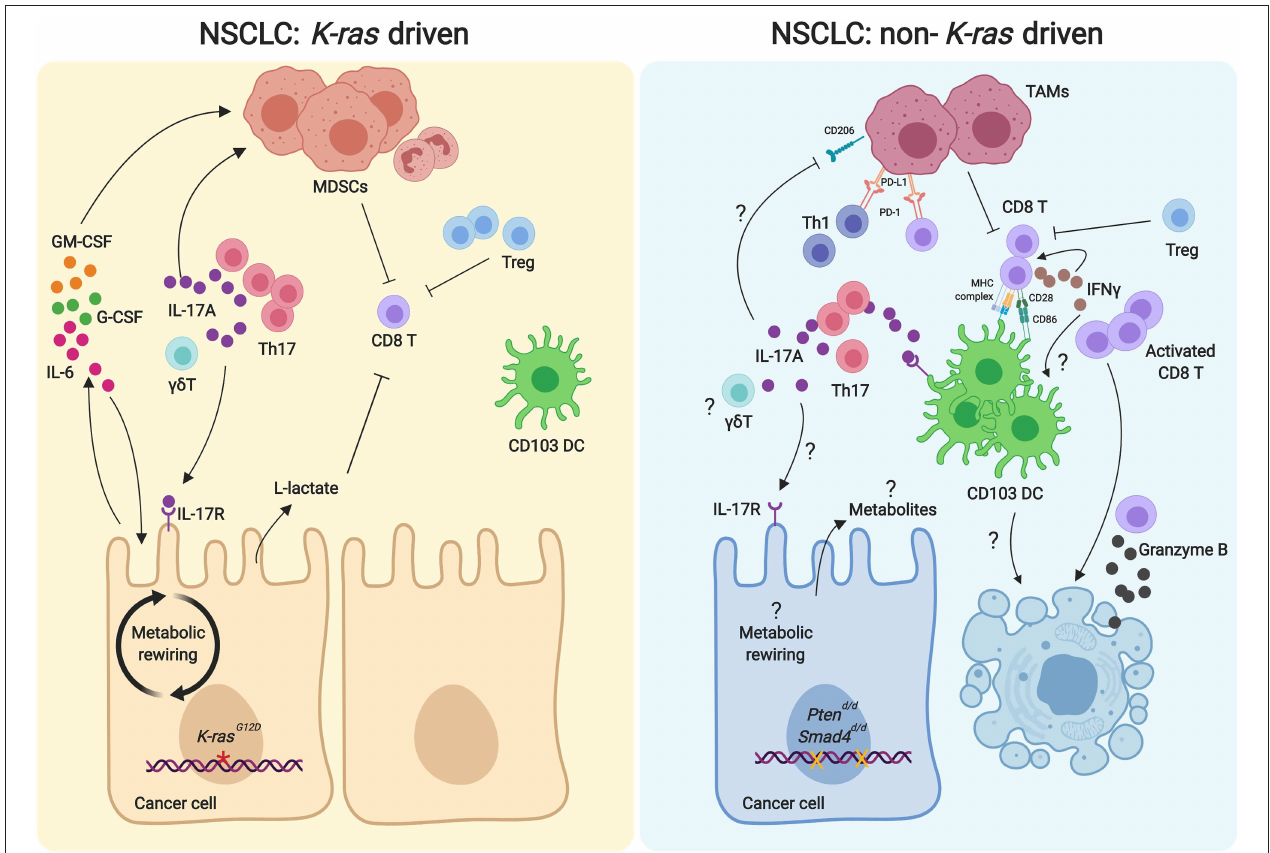
FIGURE 1 | Comparison of Th17/IL17A axis in the tumor microenvironments of K-ras -driven and Pts d / d NSCLC models. In the K-ras -driven models of NSCLC ( Left ), Th17 cells are recruited to the tumor microenvironment to promote tumor cell growth. Th17 derived IL17A recruits MDSCs to suppress the anti-tumor activity of CD8T cells. Increased Tregs and the glycolytic metabolite lactate in the tumor microenvironment can also inhibit the CD8T cell activation. IL17A can directly signal the tumor cells, resulting in increased IL-6 expression. IL-6 can act as an autocrine manner to foster the proliferation of tumor cells and paracrine manner to stimulate the MDSC recruitment. Additionally, GM-CSF and G-CSF produced by the tumor cells can further promote the infiltration of MDSCs. In contrast, Th17/IL17A in the tumor microenvironment of the Pts d / d NSCLC model inhibits tumor growth ( Right ). Th17 cells are required for the recruitment of CD103 + DCs to activate CD8T cells for their anti-tumor activity. IL17A induces increased expression of IL-17R and CD86 on CD103 DCs, which in turn provides signals for CD8T cell activation. Activated CD8T cells secrete IFN γ , which elicits CD8T cell activation and DC tumoricidal activity to kill the tumor cells. IL17A may inhibit CD206 + TAMs, resulting in decreased PD-1 and PD-L1 interaction between lymphocytes and TAMs, allowing anti-tumor activity of lymphocytes. DC, dendritic cell; γδ T, gamma delta T cell; GM-CSF, granulocyte macrophage colony stimulating factor; G-CSF, Granulocyte-colony stimulating factor; IFN γ , interferon gamma; IL-17R, IL-17 receptor; MDSC, myeloid derived suppressor cell; TAM, tumor associated macrophagel; Treg, regulatory T cell.